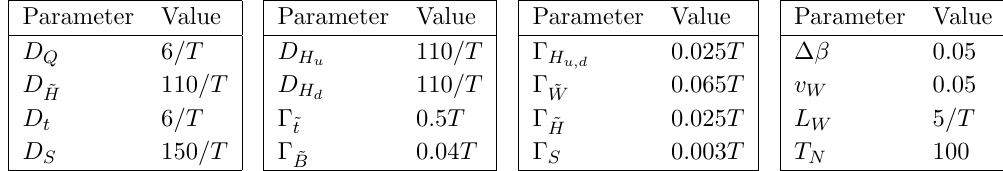
Table 1 . The base set of parameters used for our numerical study. The di(cid:11)usion constants are taken from [106]. Here a = f 1 ; 0 : 5 ; 0 : 25 g for the case where the mass of the singlet is